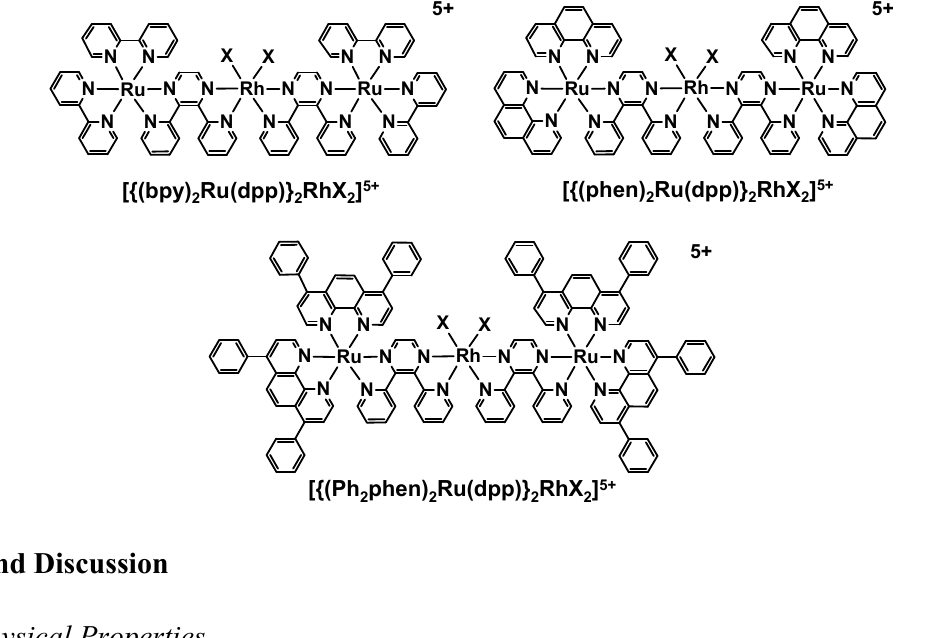
Figure 2. Ru(II),Rh(III),Ru(II) photoinitiated electron collectors of the supramolecular architecture [{(TL) phen = 1,10-phenanthroline, Ph (2-pyridyl)pyrazine; X = Cl or